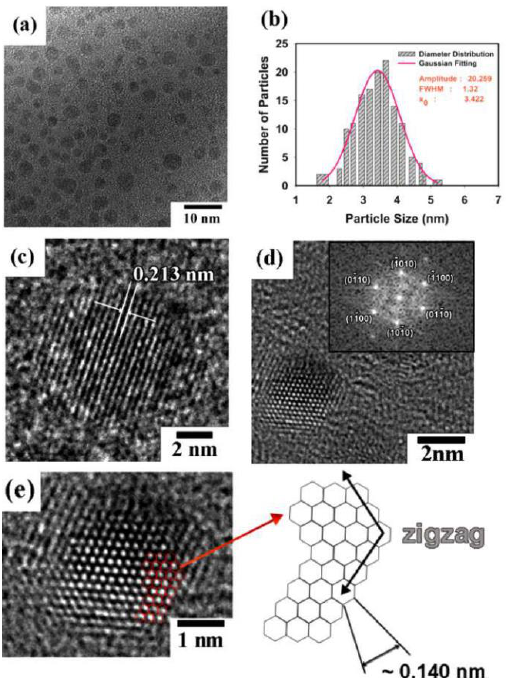
Figure 33. ( a ) HRTEM of GQDs, ( b ) size distribution, ( c ) lattice spacing, ( d ) FFT analysis, ( e ) zigzag structure of the particles’ edges. Reprinted with permission from Ref. [114]. 2013, Elsevier.